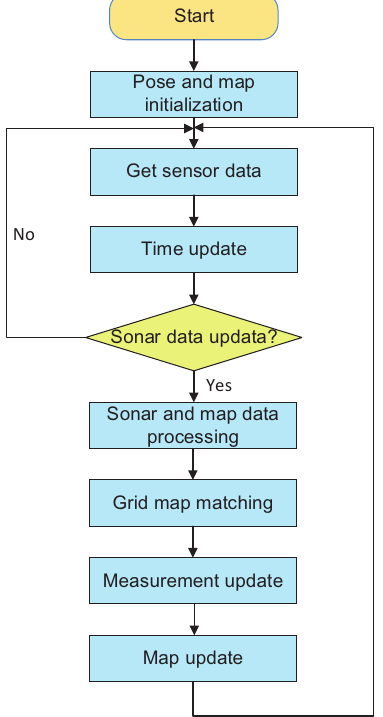
Figure 4. Occupancy grid-based AUV SLAM